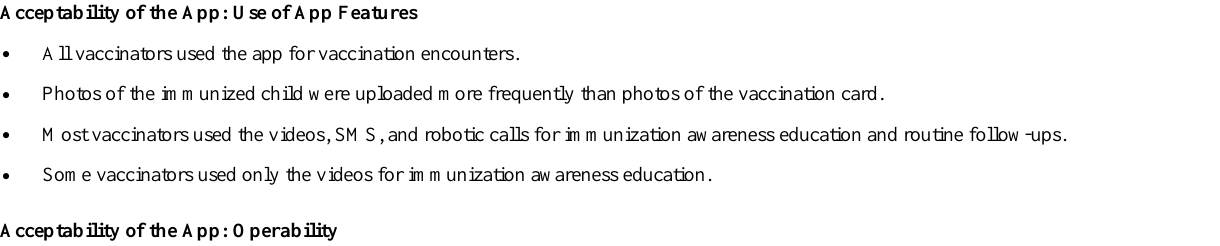
Textbox 1. Important findings from the vaccinator interviews.